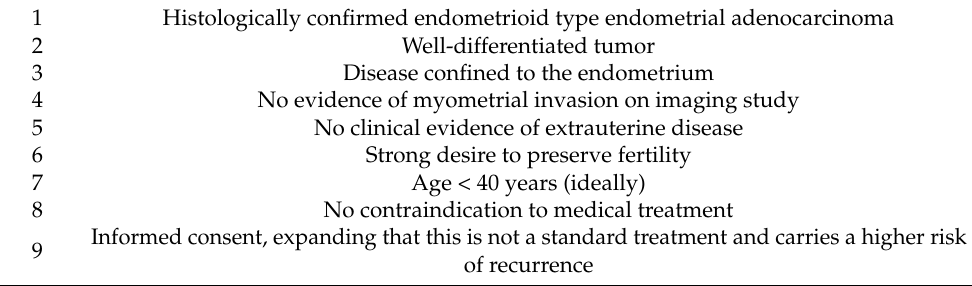
Table 1. Optimal indications for fertility-sparing